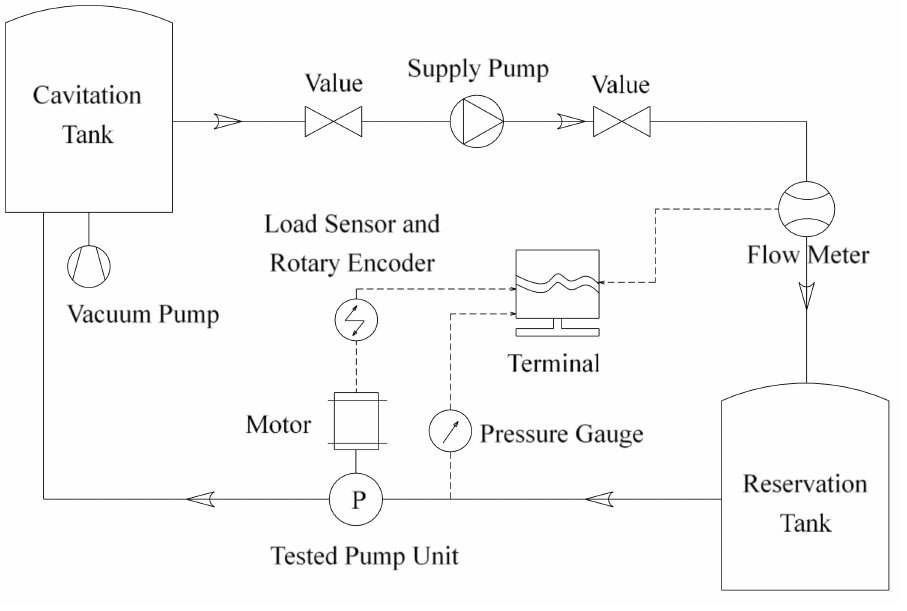
Figure 2. Schematic map of the test rig.